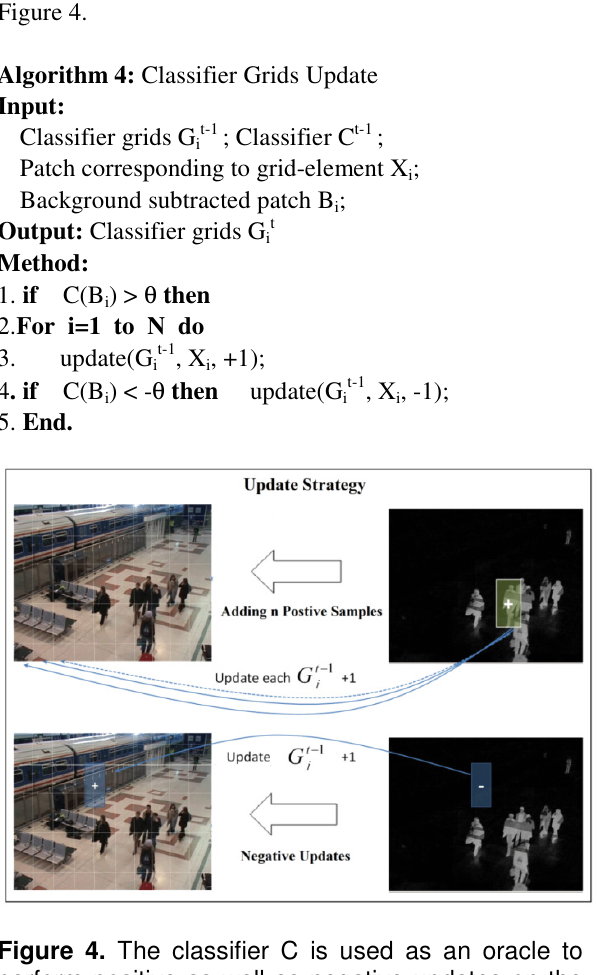
Figure 4. The classifier C is used as an oracle to perform positive as well as negative updates on the classifiers within the classifier grids. Positive updates are spread to all classifiers in the grids whereas negative updates are performed for a particular classifiers grid.